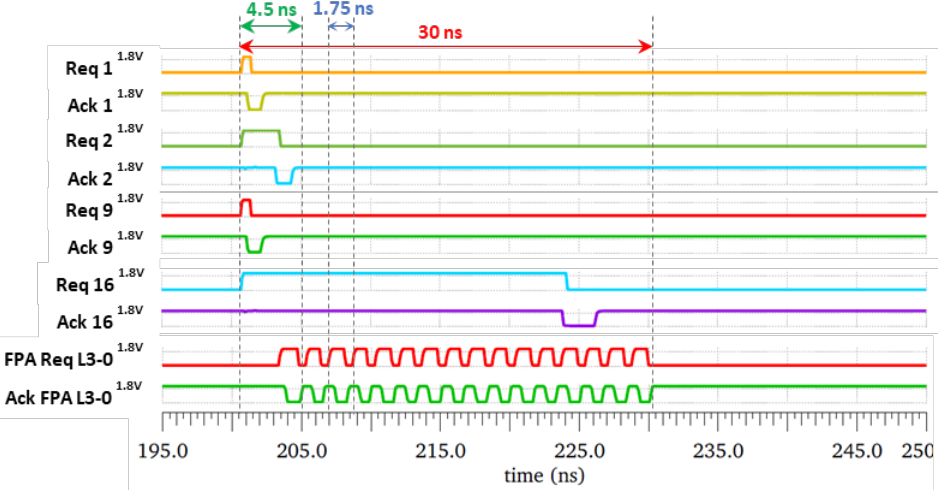
Figure 10. Best- and worst-case latencies simulation results in the case where all the 16 send units are triggered simultaneously. The highest priority datum, the Req1 signal, is extracted first with a latency of only 4.5 ns and the lowest priority datum, the Req16 signal, is extracted after all the other ones with a latency of 30 ns.